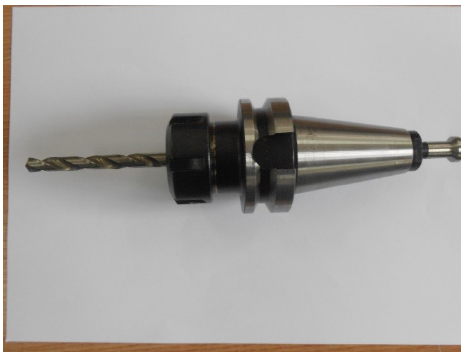
Figure 11. Bosch drill mounted with elastic bracelet.